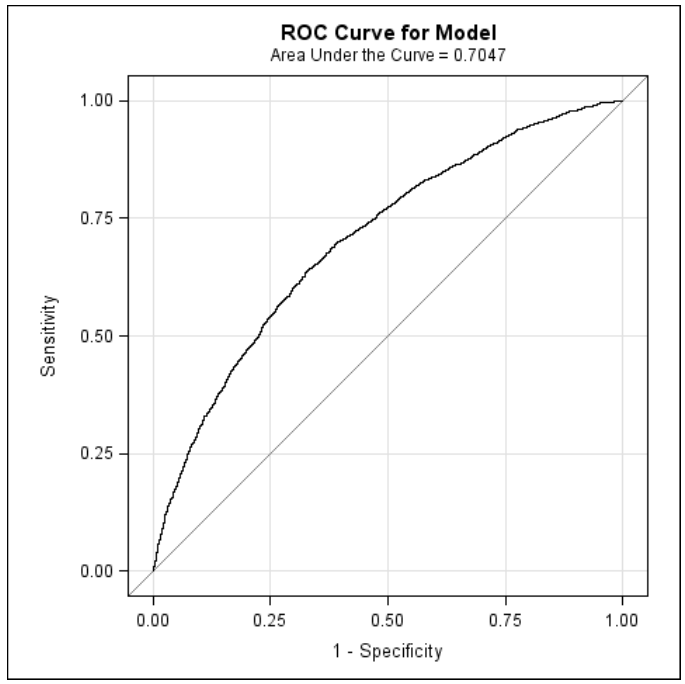
Figure 2. The receiver operating characteristic cure (ROC) for the logistic regression for propensity score. The C-statistic (area under curve, AUC) was